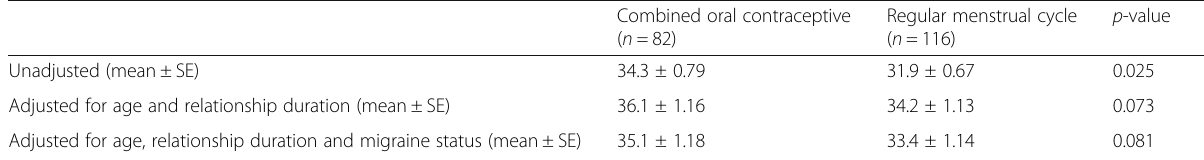
Table 3 Comparison of jealousy levels between women using COCs and women with a regular menstrual cycle